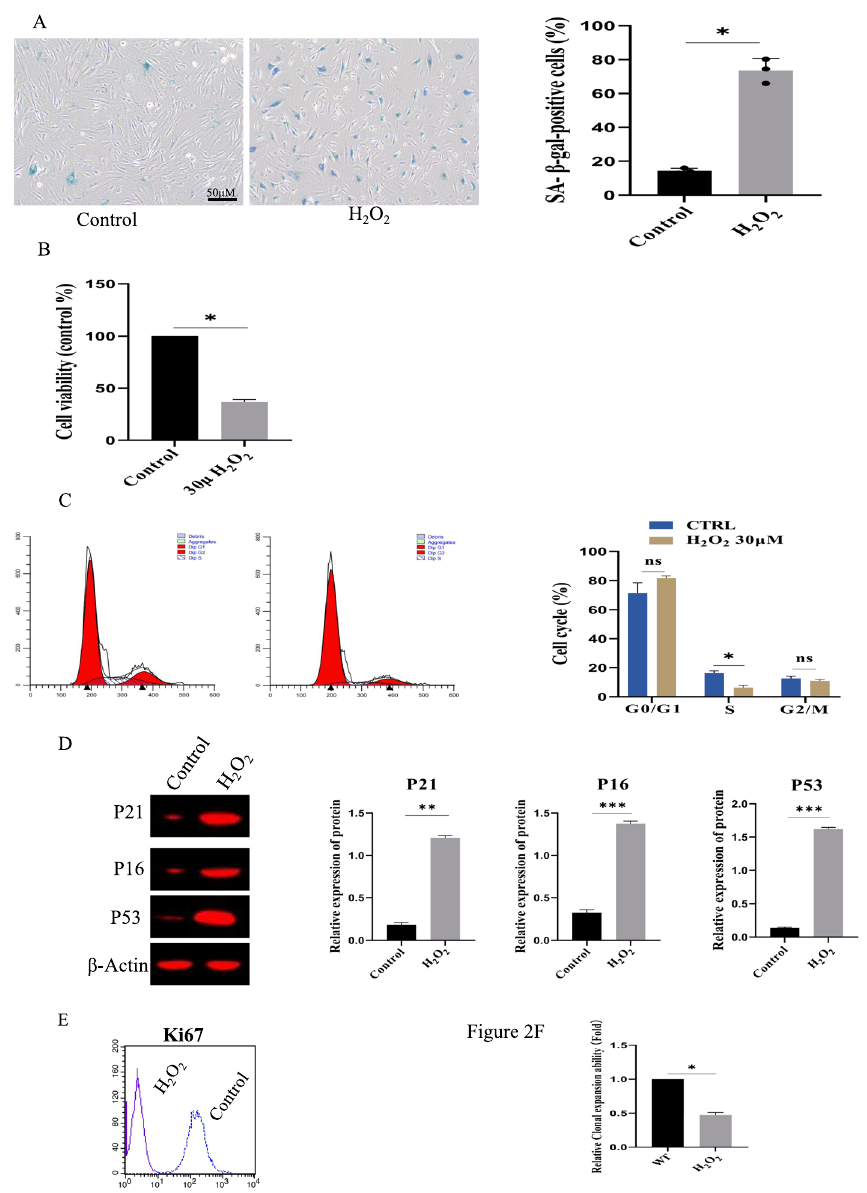
Fig. 2 Establishment of Bm-MSCs senescence model by 30 μM H 2 O 2 treatment. A The percentage of Sa-β-gal-positive cells were significantly decreased under H 2 O 2 treatment. Scale bar, 20 μm. n 5 biological = replicates. B H 2 O 2 treatment inhibited the cell proliferation of MSCs, n 3. C The effect of H 2 O 2 (30 μM) = treatment on cell cycle phase by Flow cytometry analyses. D The expression of p21, p16 and p53 was down-regulated under H 2 O 2 (n 3). E The expression of Ki67 was down-regulated. At least 50 cells were = statistically analyzed. F Clone expansion capability was reduced by H 2 O 2 (n =